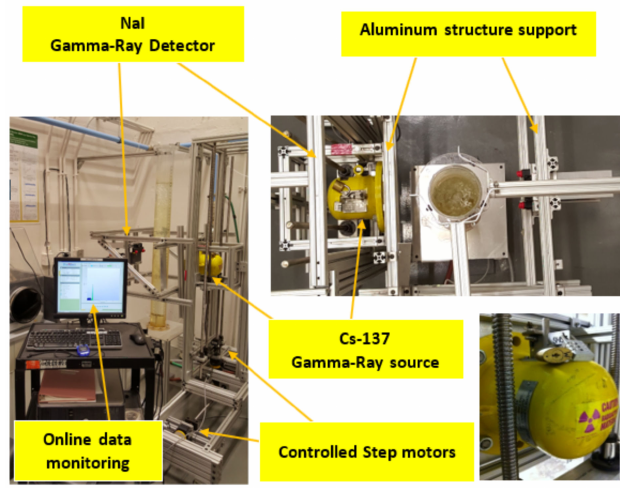
Figure 2. Picture of GRD technique and Split Airlift Reactor.